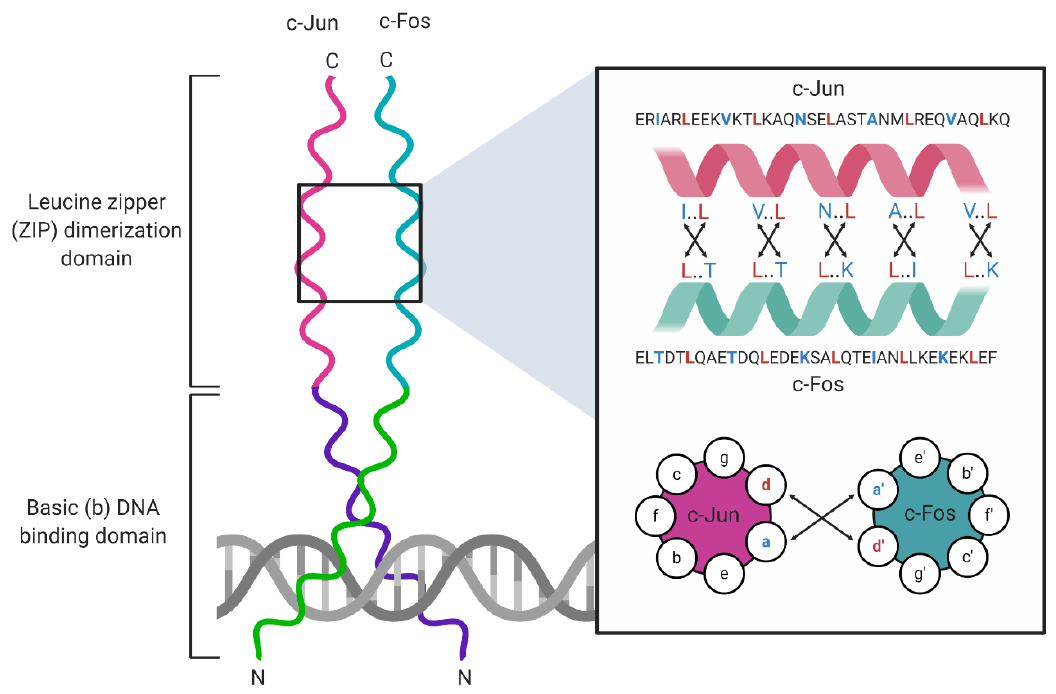
Figure 1. Structure of the c-Jun/c-Fos heterodimer. The c-Jun/c-Fos complexes bind DNA as heterodimers. Each bZIP protein contains a leucine zipper (ZIP) and adjacent basic (b) DNA-binding domain that together constitute the bZIP domain. The ZIP domain organizes into heptad repeats with amino acid residues denoted as positions a–g. Hydrophobic interactions (black arrows) between a (blue) and d (red) residues stabilize dimer formation [6]).